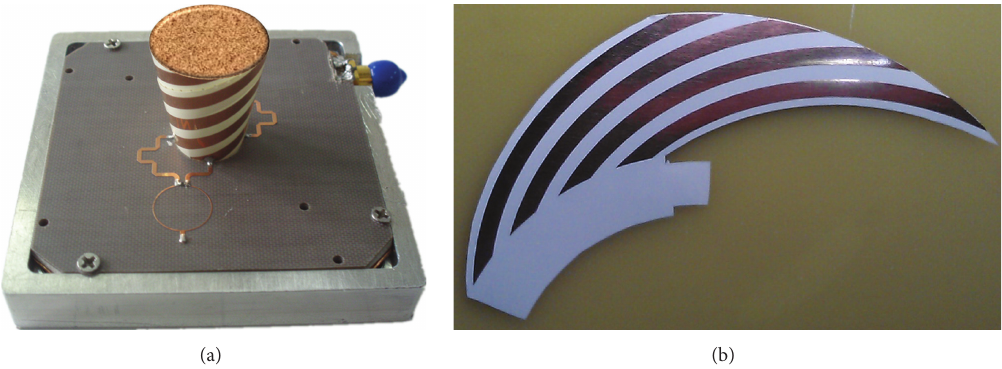
Figure 7: Fabricated prototype of the test antenna. (a) Integral structure. (b) Unwrapped helix